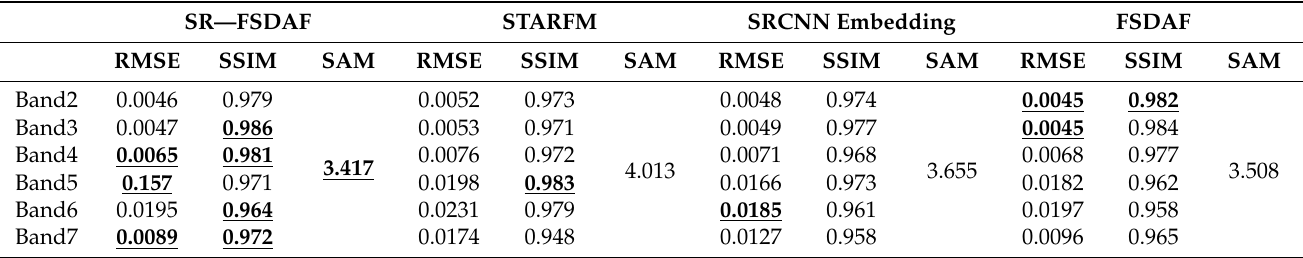
Table 4. Comparison of fusion accuracy of non-heterogeneous mutation